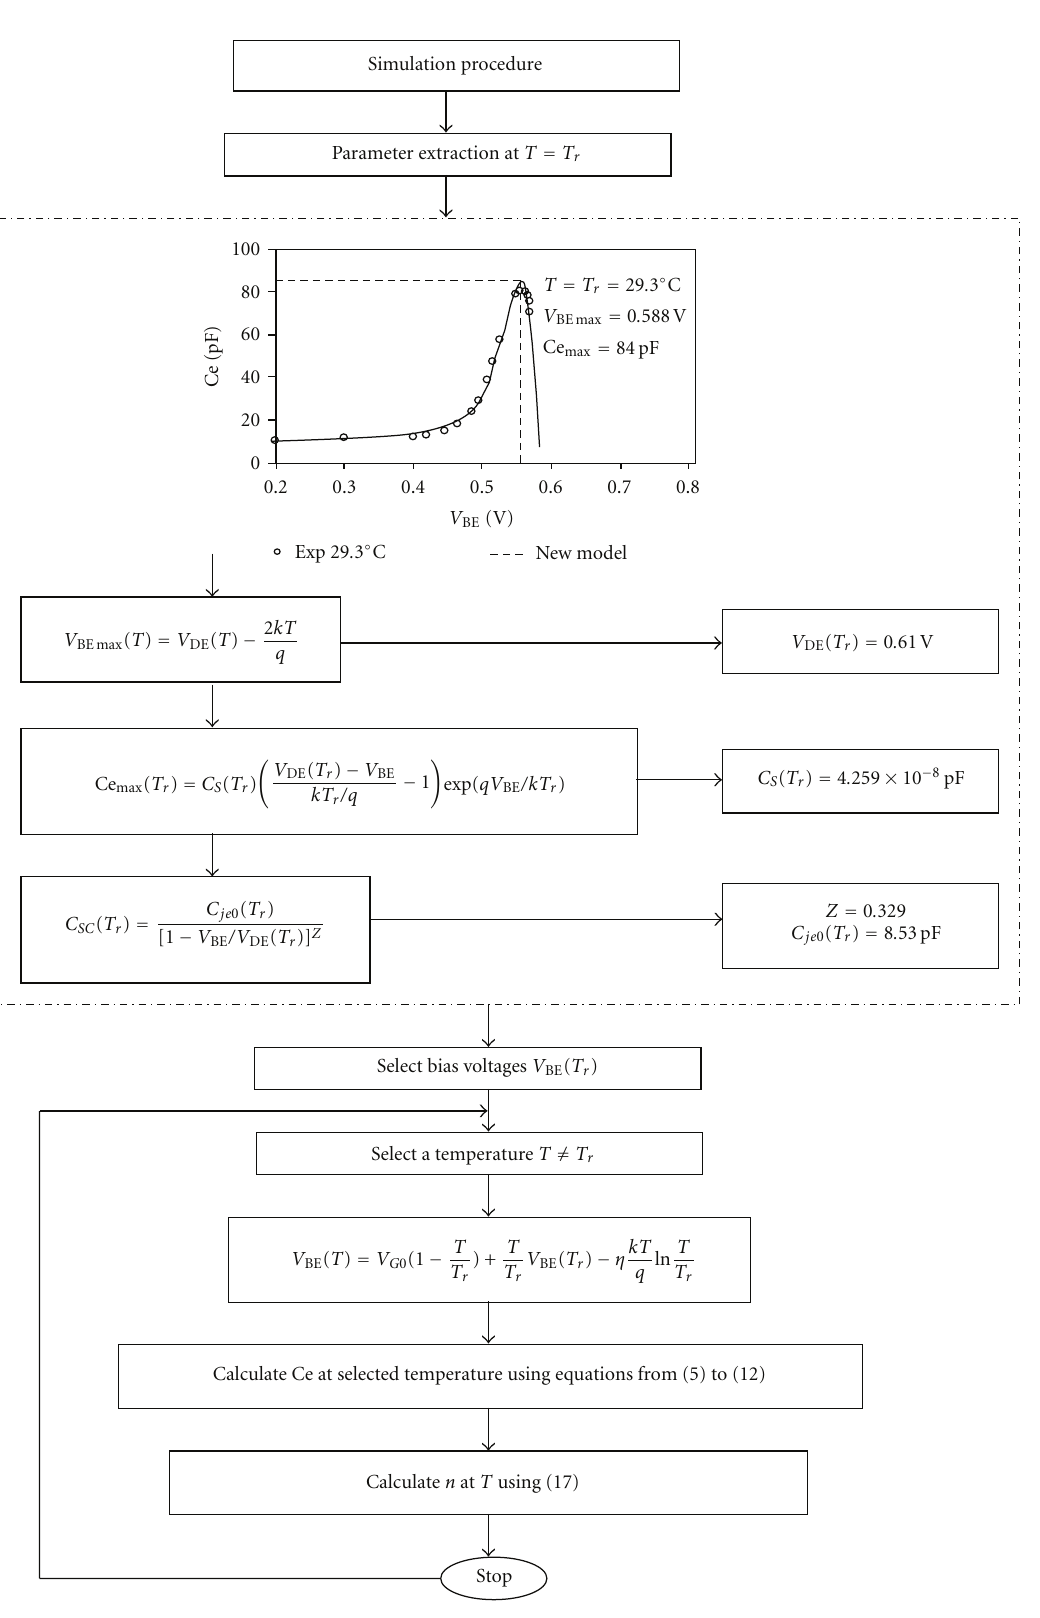
Figure 4: Flow chart: simulation procedure to obtain n ( T